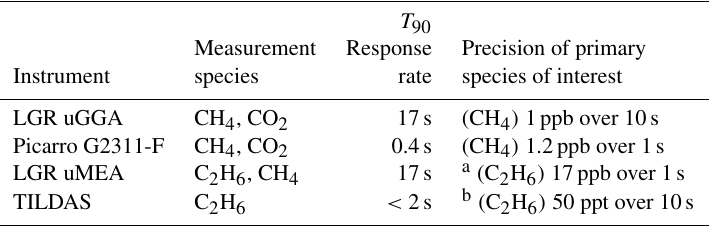
Table A1. Response rates and precision for the instrument set-up on the BAS Twin Otter. All measurements were time-shifted to match the Picarro G2311-f for analysis.